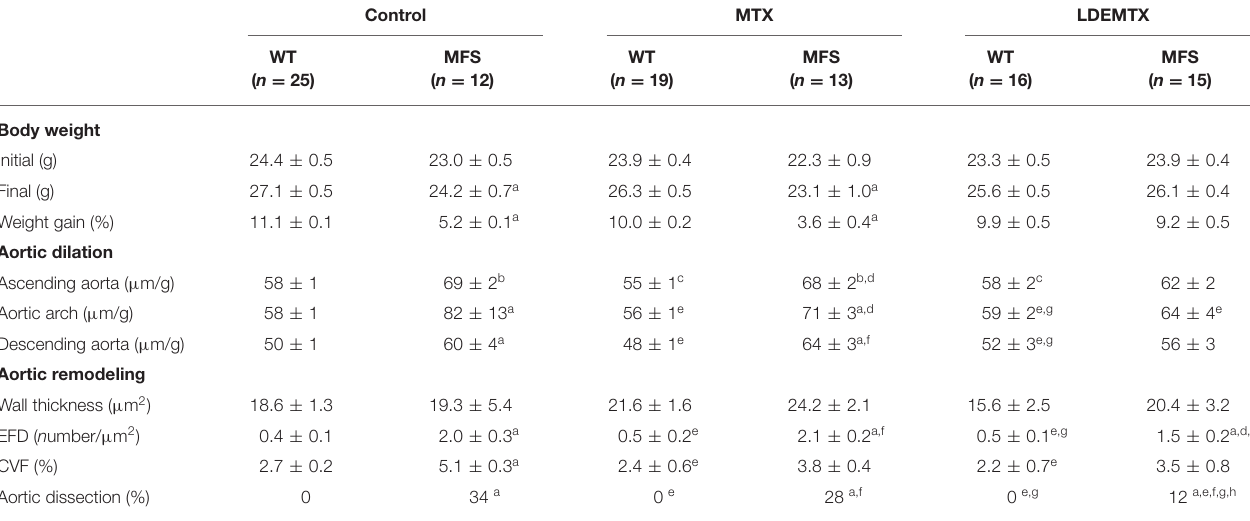
TABLE 1 | Body weight, echocardiographic and morphometric parameters in WT and MFS mice with 6 months of age after MTX and LDEMTX treatments.